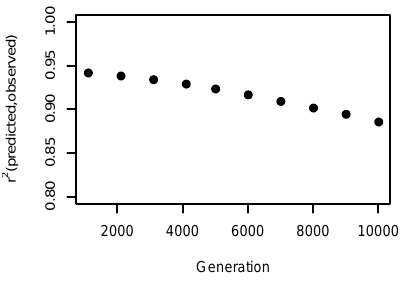
Figure SI8 – Accuracy of the prediction vs. simulation time. Effect of the number of gen- erations on the proportionality relationship between predicted and observed evolvabili- 2 ties of robustness components. The figure displays the r of a linear regression (without intercept) between the predicted evolvability from the conditional M c matrix measured at the first generation and the observed evolvability in the direction of selection for all replicated simulations. The regression at generation 1,000 is illustrated in the colored inset in Figure